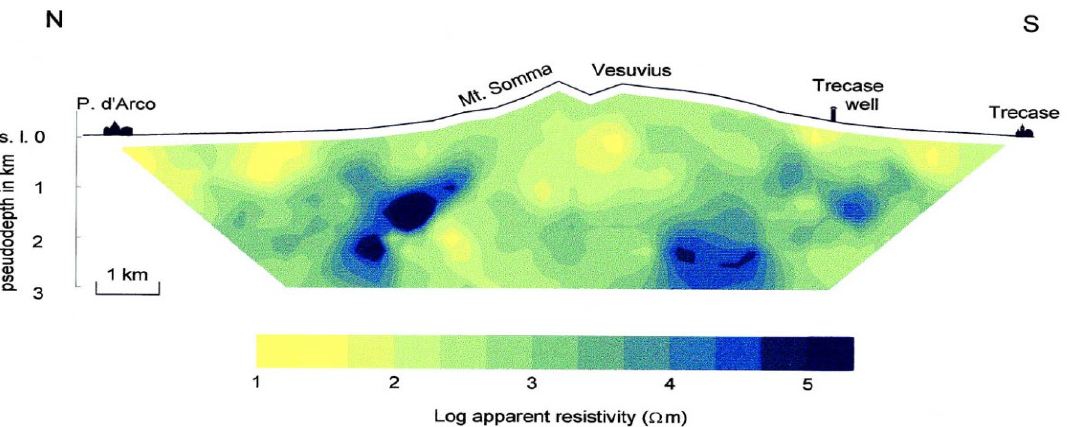
Figure 3. 2D Apparent resistivity pseudosection carried out on Vesuvius (Reprinted with permission from [27], Copyright (1998), Elsevier).